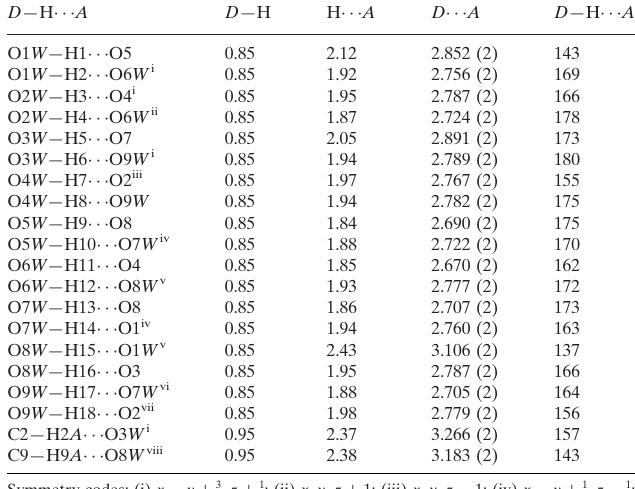
Data collection Bruker APEXII CCD area-detector diffractometer Absorption correction: multi-scan ( SADABS ; Bruker, 2005) T min = 0.760, T max = 0.888 Refinement